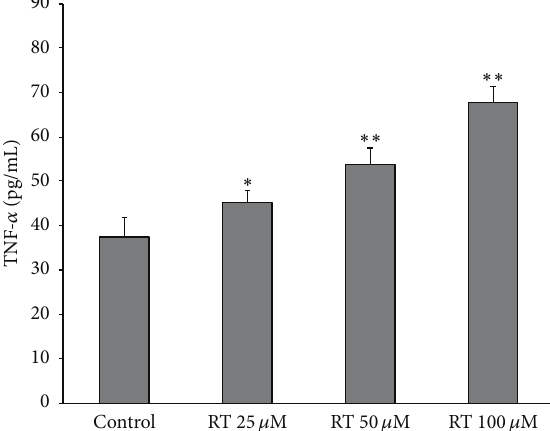
Figure 5: The effects of rutin on TNF- 𝛼 secretion. The results of ELISA measuring TNF- 𝛼 contents in the supernatants of LAN-5 cells treated with 0, 25, 50 and 100 𝜇 M rutin (RT 25 𝜇 M, RT 50 𝜇 M or RT 100 𝜇 M) for 24h. Data shown are the means of three experiments. ∗ 𝑃 < 0.05 ; ∗∗ 𝑃 < 0.01 compared to